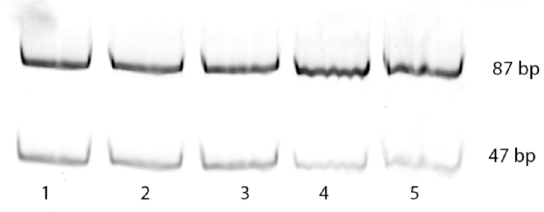
Figure 2. Electrophoregram of the double-stranded products obtained in the extracts of cell nuclei and digested with EcoRI : 1—testis, 2—liver, 3—brain, 4—kidney, 5—breast. The percent of 47 bp band was taken as the mutagenic potential of 8-oxoG.